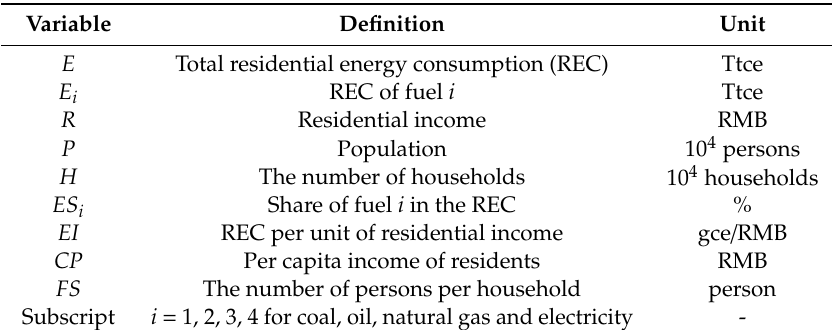
Table 2. Definition of variables in Equation